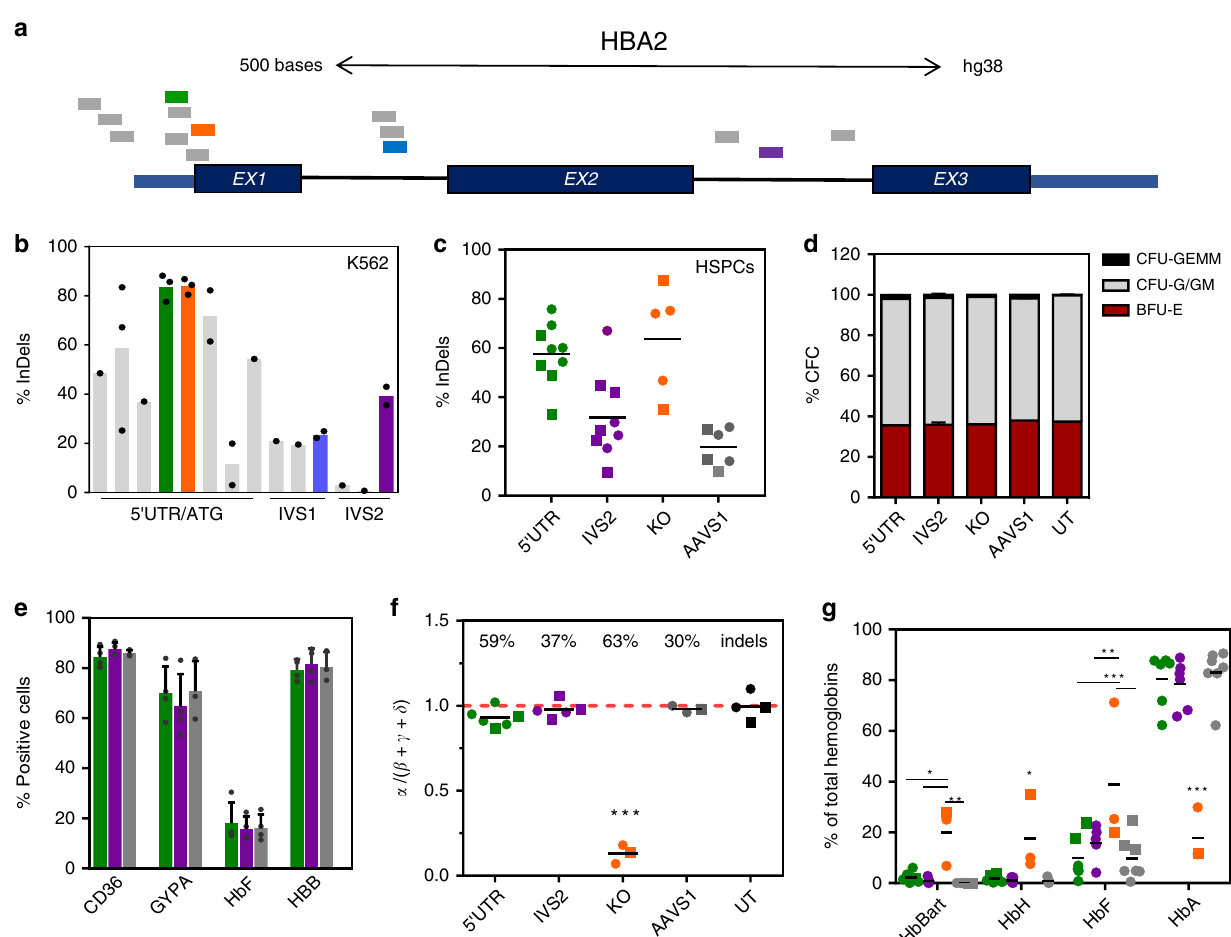
Fig. 1 Editing of selected sites in the α -globin locus minimally affects globin production. a Locations of gRNA on HBA2 gene. All gRNA except 74 (in purple) target both HBA1 and HBA2. Selected gRNA are highlighted. b K562-Cas9 screening of gRNA targeting different region of the α -globin locus (5 ′ untranslated region/start codon (5 ′ UTR/ATG), intron 1 (IVS1) or intron 2 (IVS2)). Each bar is a different gRNA, each dot a different experiment. Editing ef fi ciency is expressed as percentage of modi fi ed HBA alleles (bars represent mean; data from 1, 2 or 3 biological replicates). The gRNA selected for each region are highlighted. c Editing ef fi ciencies in HSPCs in erythroid liquid culture (circles) or in BFU-E (burst-forming unit-erythroid, squares). Lines show mean (2-4 donors; n = 5 KO, n = 6 AAVS1, n = 9 5 ′ UTR and IVS2). d Colony-forming cell (CFC) frequency in edited HSPCs (mean ± SD; n = 2, n = 4 for IVS2). CFU-GEMM, granulocyte, erythroid, macrophage, megakaryocyte; BFU-E, burst-forming unit-erythroid; CFU-G/GM, granulocyte-macrophage. e Flow-cytometry analysis of erythroid markers upon differentiation of edited HSPCs, day12 (green 5 ′ UTR, purple IVS2 and gray AAVS1). Results are shown as mean ± SD ( n = 3 biological replicates, 3 different donors; p = 0.94, one-way ANOVA Tukey ’ s test). f HPLC analysis of hemoglobin monomers of erythroblasts derived from edited HSPCs ( n = 6 5 ′ UTR, n = 5 IVS2, n = 3 KO and AAVS1, n = 4 UT; 4 donors). InDels percentage mean is indicated. The ratio α / β -like globins in normal cells is close to 1 (red dashed line). Black lines show mean; BFU-E (squares), erythroid liquid culture (circles) (*** p < 0.001 vs UT, 5 ′ UTR, IVS2, AAVS1; one-way ANOVA, Tukey ’ s test). g HPLC analysis of hemoglobin tetramers of erythroblasts derived from edited HSPCs (same samples as in f ). Every tetramer is reported as % of total hemoglobins (* p < 0.05; ** p < 0.01, *** p < 0.001; two-way ANOVA, Dunnet ’ s test). Black lines show mean; BFU-E (squares), erythroid liquid culture (circles). Hb Bart, γ 4 ( p = 0.017 5 ′ UTR, p = 0.013 IVS2, p = 0.006 AAVS1 vs KO); HbH, β 4 ( p = 0.038 5 ′ UTR, p = 0.035 IVS2, p = 0.032 AAVS1 vs KO); HbF, fetal hemoglobin, α 2 γ 2 ( p < 0.001 5 ′ UTR and AAVS1, p = 0.002 IVS2 vs KO); HbA, adult hemoglobin, α 2 β 2 ( p < 0.001 vs KO). Source data are in the Source Data fi